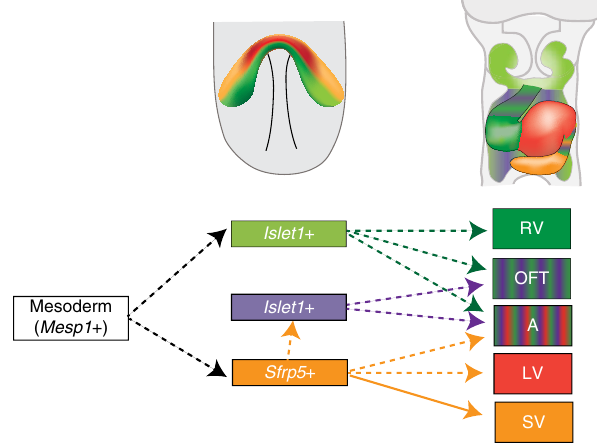
Figure 5 | Model for the contribution of Sfrp5 -expressing cardiac precursors to heart development. Upper panels show the expression area of Sfrp5 (orange) and Islet1 (light green) and the distribution of descendants of Sfrp5- expressing (red) and Islet1- expressing (green) cells at E7.5 (right) and E9.5 (left). The lower panel shows the lineage contribution to each part of the heart. Mesodermal cells, which transiently express Mesp1, may become cardiac precursor cells expressing Islet1 (light green) or Sfrp5 (orange). A portion of Sfrp5 -expressing cells later begins to express Islet1 (purple). Transient Islet1- expressing cells that do not express Sfrp5 contribute to the RV, OFT and atrium (green), and cells that express Sfrp5 contribute to the OFT and atrium (purple) but not to the RV. Cells that transiently express Sfrp5 contribute to the LV, atrium and OFT (orange), and cells that continuously express Sfrp5 form the